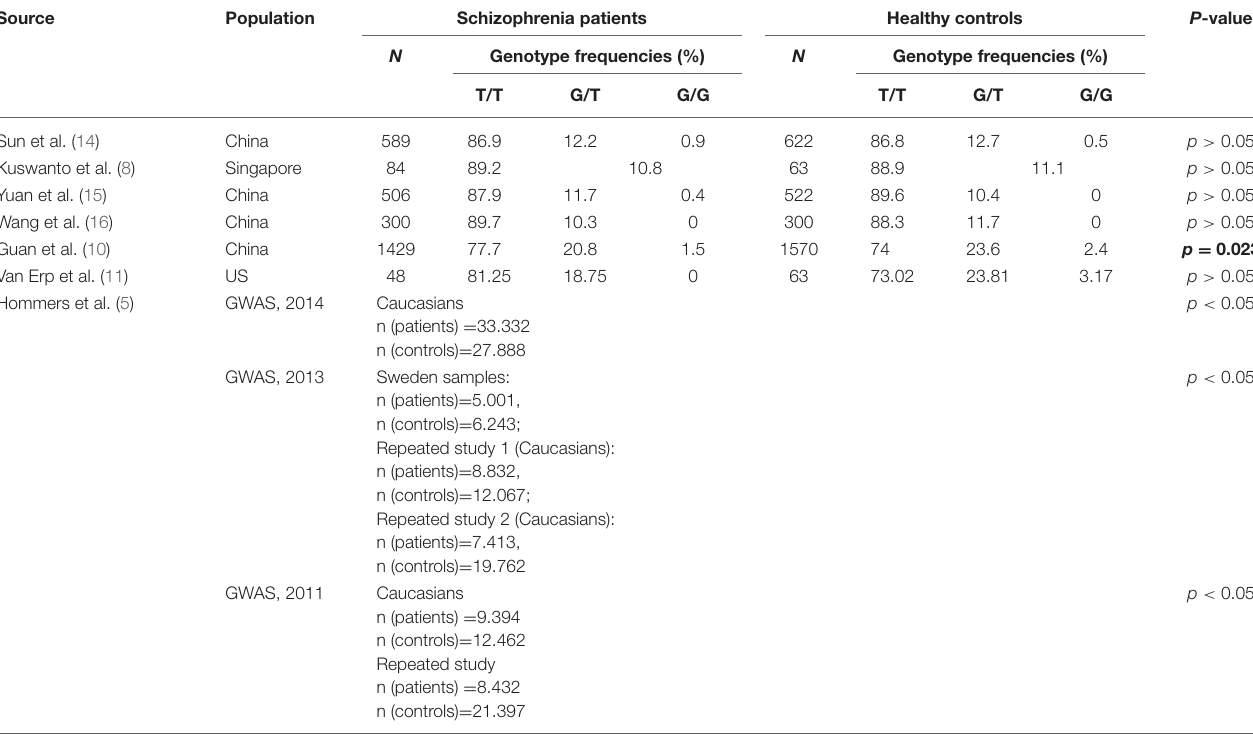
TABLE 1 | Association studies of MIR137 rs1625579 polymorphism with risk of schizophrenia. Source